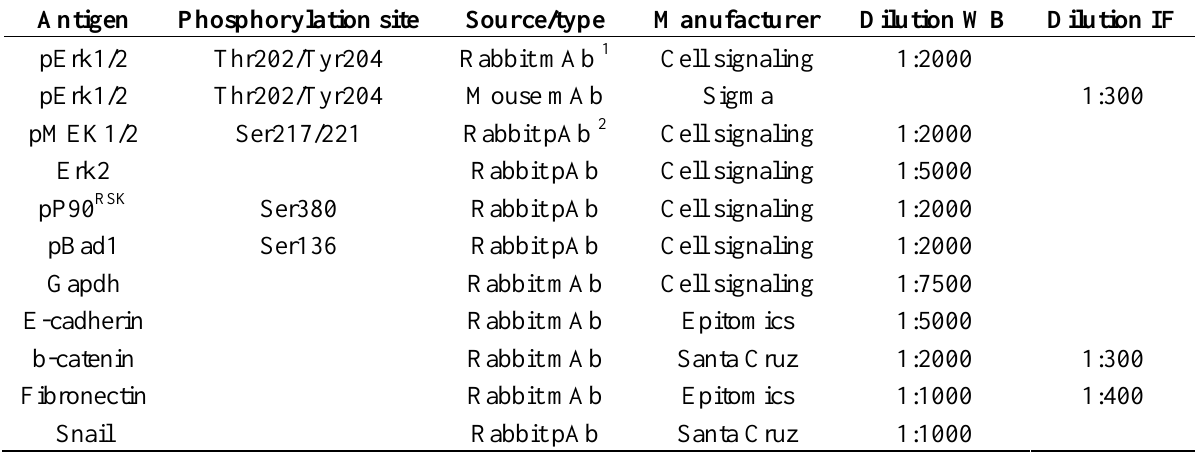
Table 1. Primary antibodies used for Western blot and Immunofluorescence